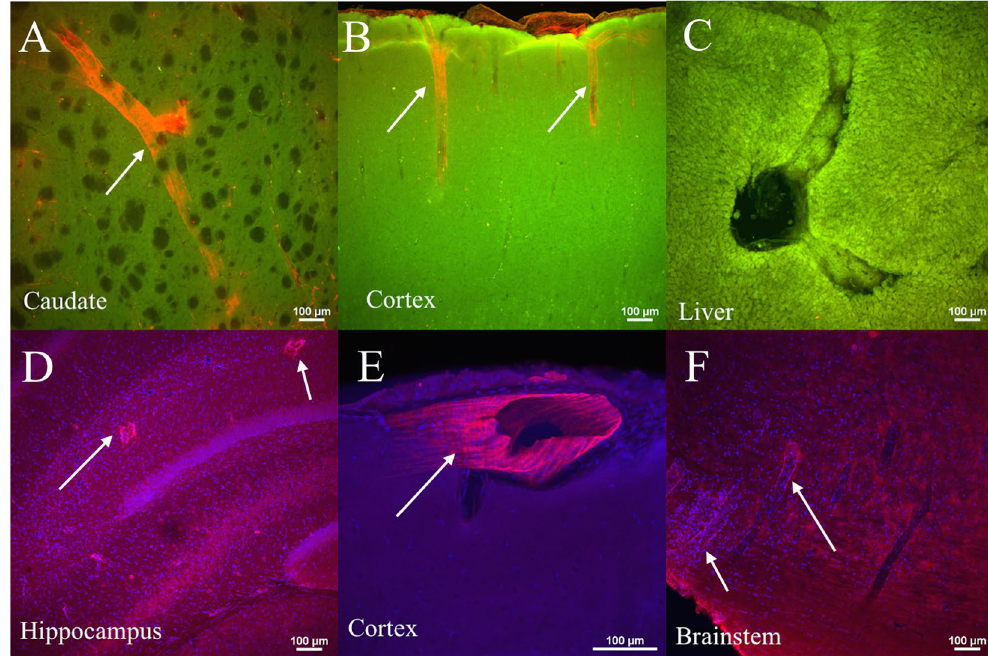
Figure 6. Laser confocal fluorescence images of different regions of the brain, and liver obtained after tracer infusion into the lateral ventricle and ex vivo MR imaging. ( A – C ) Tracer fluorescence images (red) overlaid with tissue autofluorescence image (green). ( D – F ) Tracer fluorescence images (red) overlaid with DAPI image (blue) for anatomical reference. Notice perivascular labelling (white arrows) shown by intense orange and pink regions in top and bottom row images respectively, and the absence of labeling in a hepatic blood vessel showing the tracer is abluminal in the